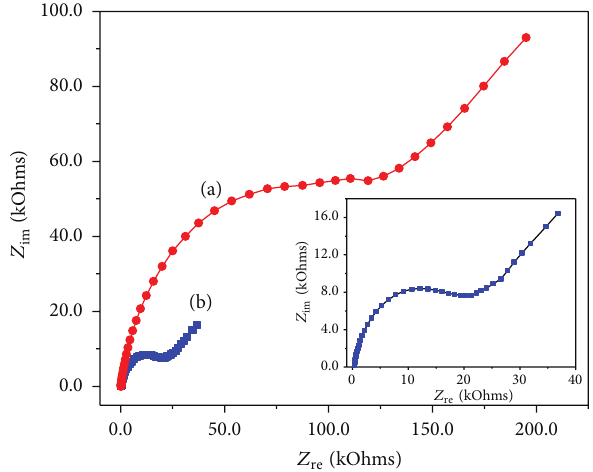
Figure 8: Electrochemical impedance spectra (EIS) obtained for (a) bare GC and (b) 𝛼 -Fe 2 O 3 nanoparticle-modified electrode in 1 × 10 −3 M K 3 [Fe(CN) 6 ] in 0.1 M KCl. ( Inset ) Expanded view of EIS of 𝛼 -Fe 2 O 3 nanoparticle-modified electrode.